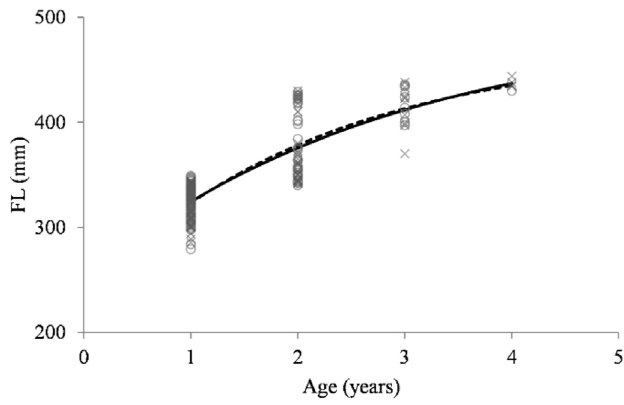
Fig. 7. von Bertalanffy growth curves for females ( ) and males ( ) of Auxis thazard landed in Southeastern Brazil between March 2018 and February 2019. Symbols represent observed lengths for females ( ○ ) and males ( (cid:1)